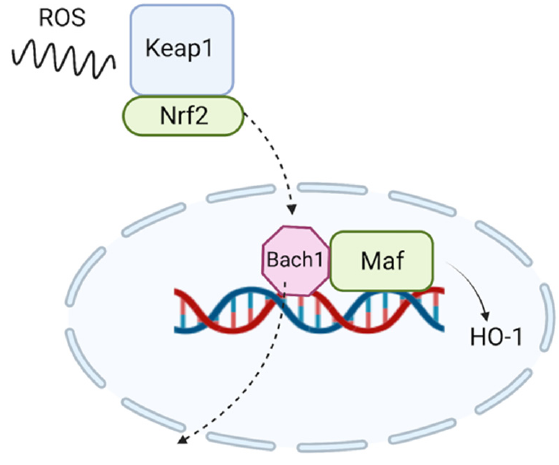
Figure 2. Under the action of reactive oxygen species (ROS), the Keap1-Nrf2 complex cleaves. Once cleaved, Nrf2 enters the nucleus at the DNA level, where it displaces Bach1 from Maf, in order to synthesize HO-1. Created with BioRender.com.